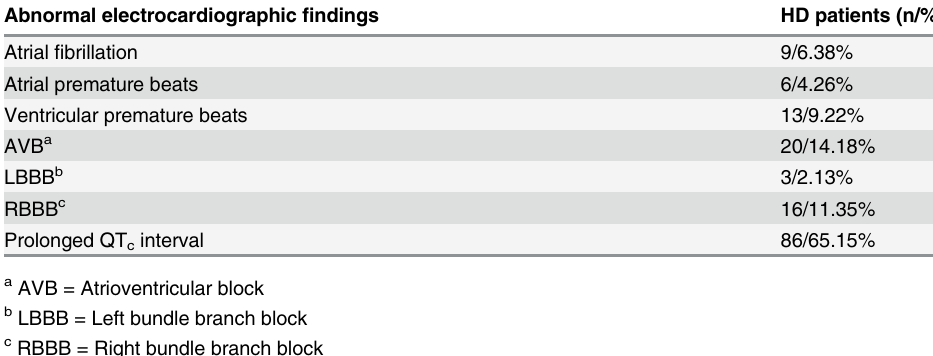
Table 2. Electrocardiographic variables in patients undergoing HD (n = 141). Abnormal electrocardiographic fi